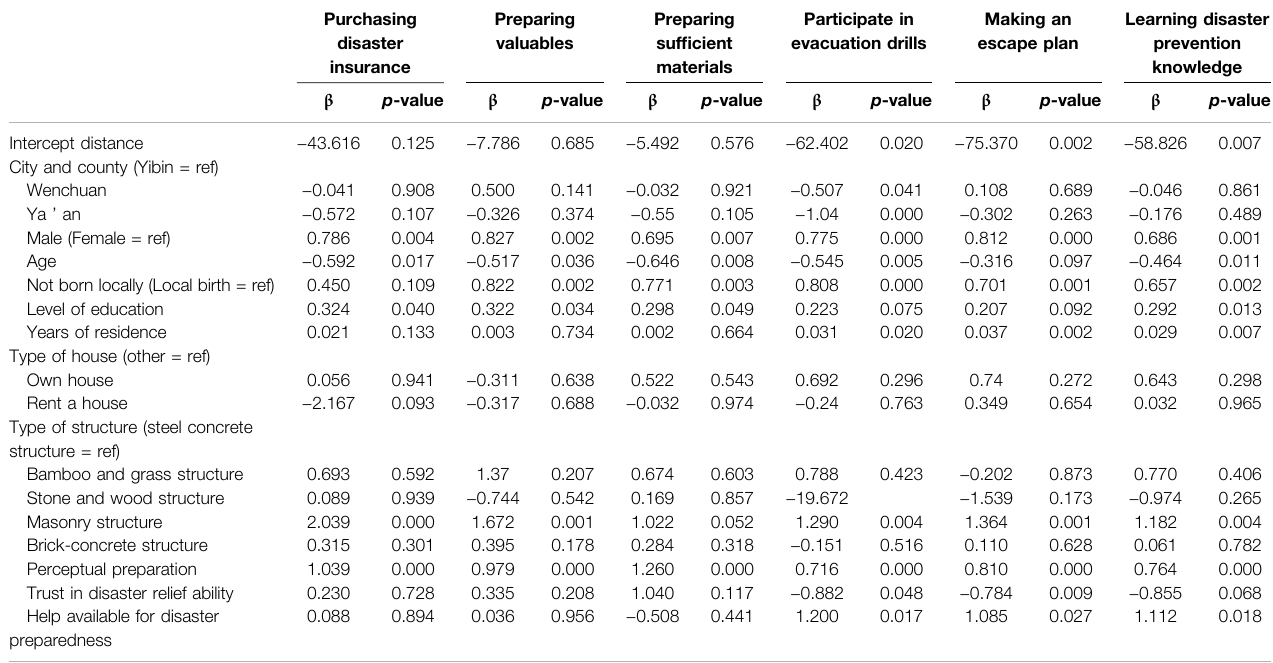
TABLE 7 | MNL model parameter estimation (ref = reference group; β =